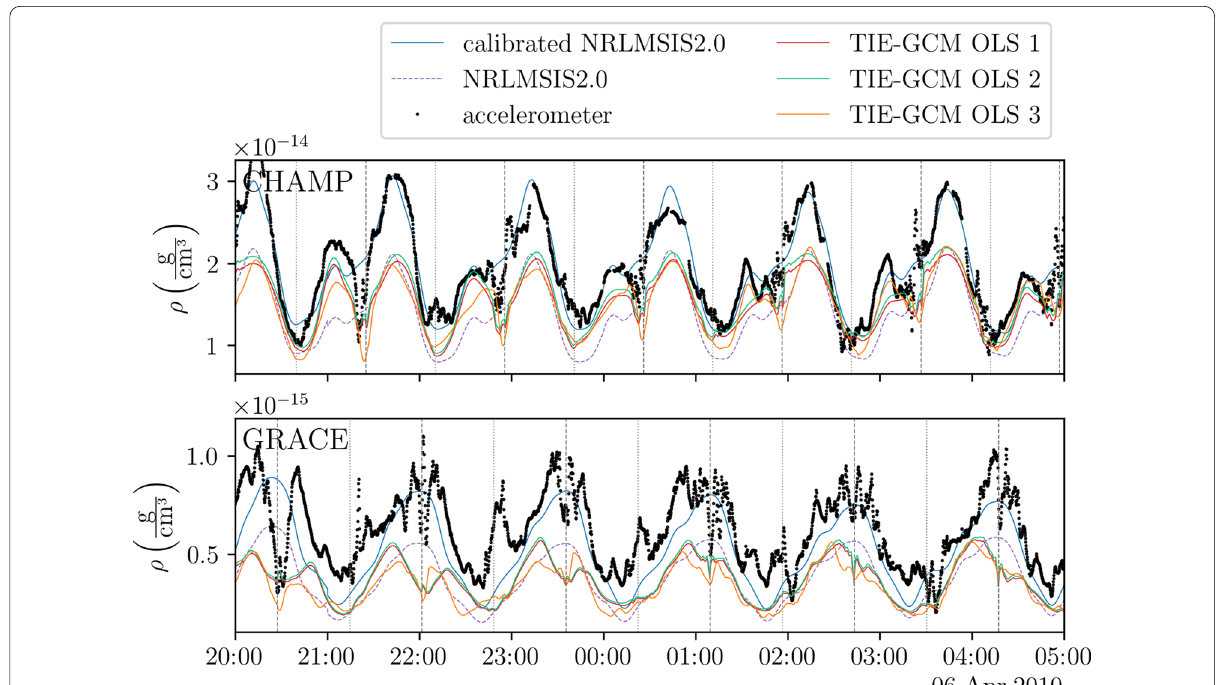
Fig. 4 The neutral mass density along the orbits of CHAMP and GRACE is plotted for a nine hour long period. The dashed vertical gray lines indicate the transits above the north pole and the dotted vertical gray lines the transits above the south pole. The calibrated NRLMSIS 2.0 time series was computed using scale factors filtered with a cut-off frequency of eight